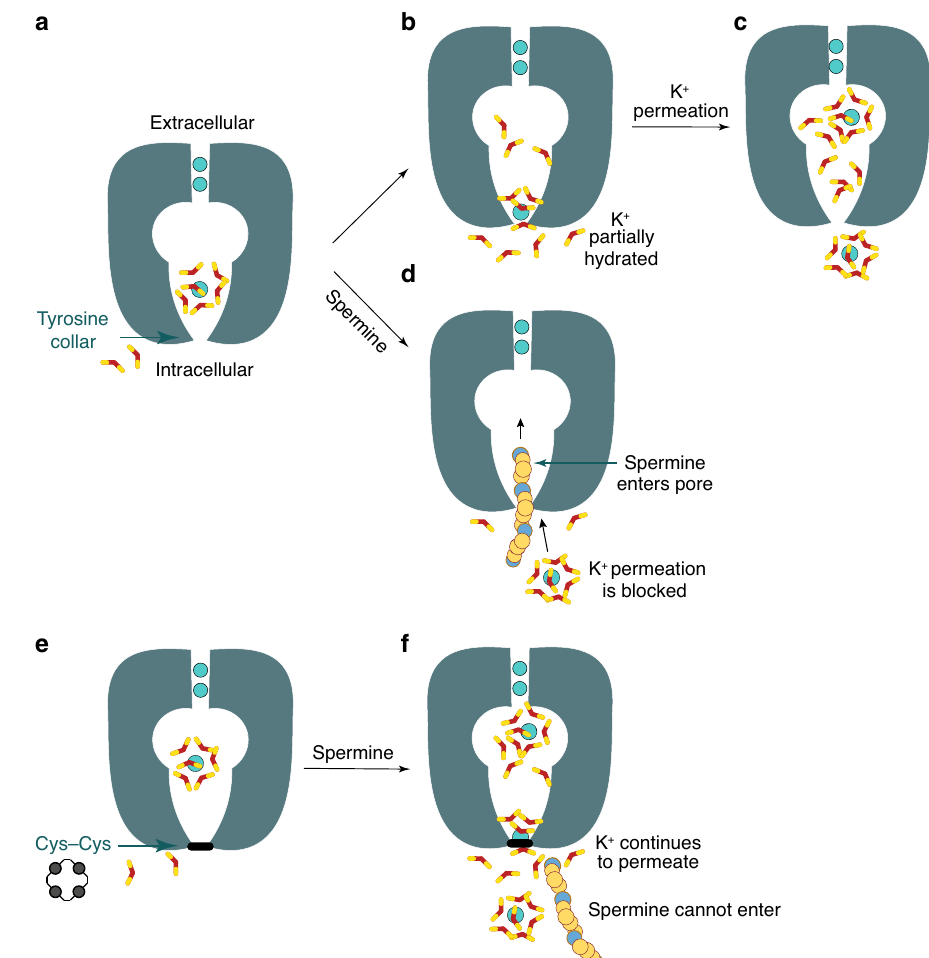
Fig. 6 Schematic representation of the fi ndings. a A hydrated K + (cyan sphere) within the wild-type Kir pore has a hydration shell of 6 – 7 water molecules (red and yellow sticks). b As the pore narrows to a bottleneck, the ion partially dehydrates by shedding 3 – 4 water molecules. c The hydration shell of K + is replenished from the other side of the opening. d A spermine molecule penetrates into the cavity of the wild-type channel, preventing outward ion conduction. e When the Tyr132 collar is disul fi de-linked, f K + permeates but spermine cannot enter the conduction